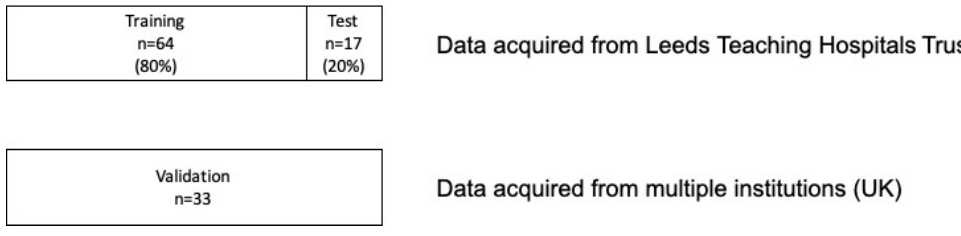
Figure 2. The distribution of datasets into training, test and validation